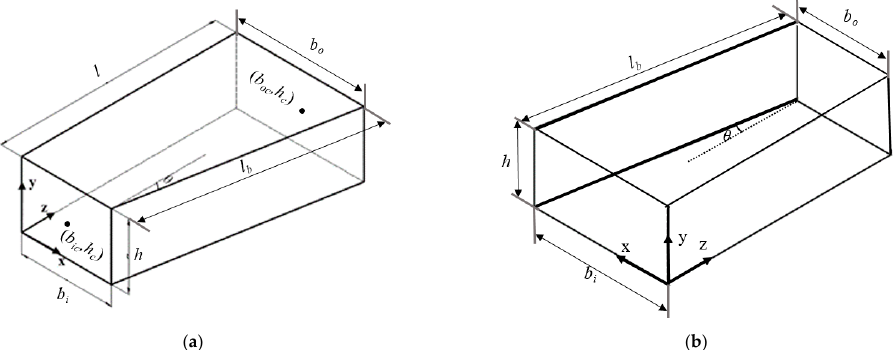
Figure 3. ( a ) A rectangular duct with expanding sections, ( b ) a rectangular duct with shrinking sections.